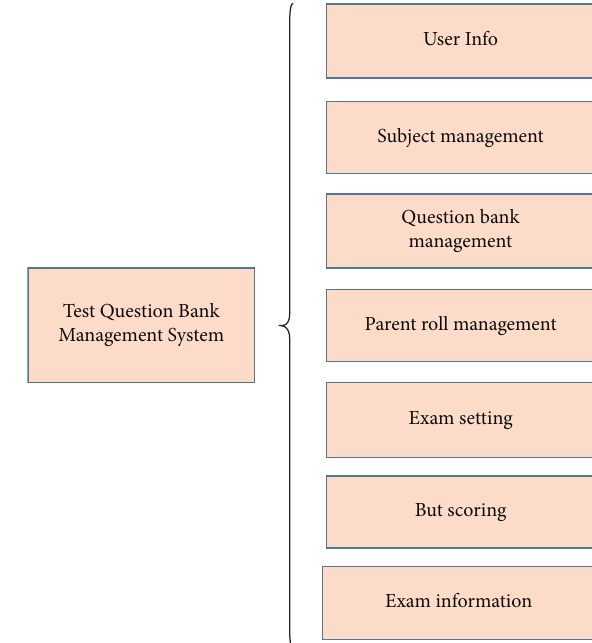
Figure 6: System function module